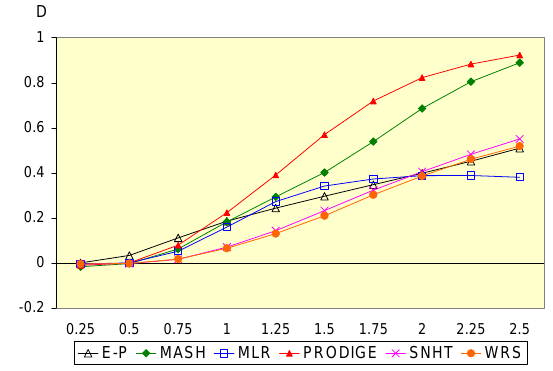
Figure 5. Detection skill for all IHs of Fig. 3. On the abscissa the unit is s d .